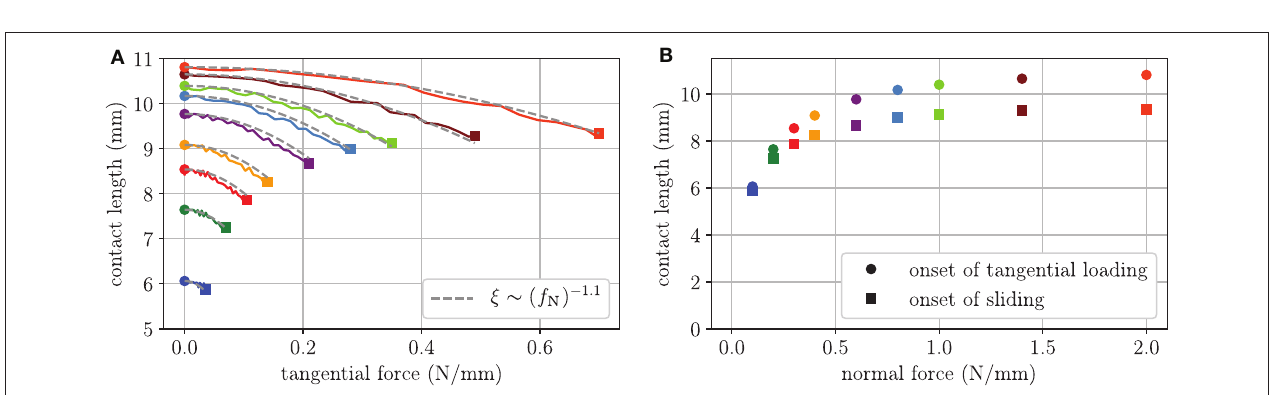
0.35 and F N 0.8 N/mm. = =